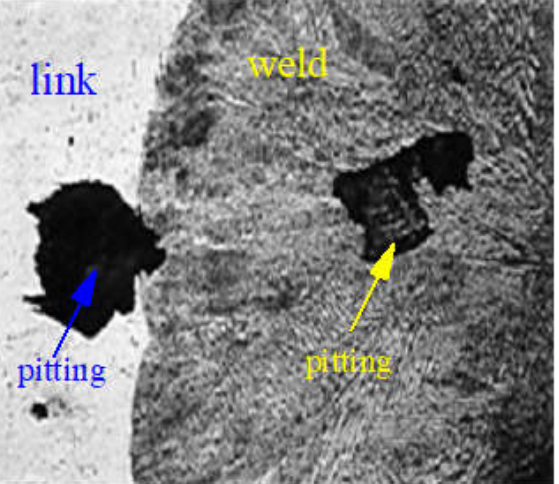
Figure 12. The average potentiodynamic polarization curves for the weld, link and link/weld interface areas. Sample #3.